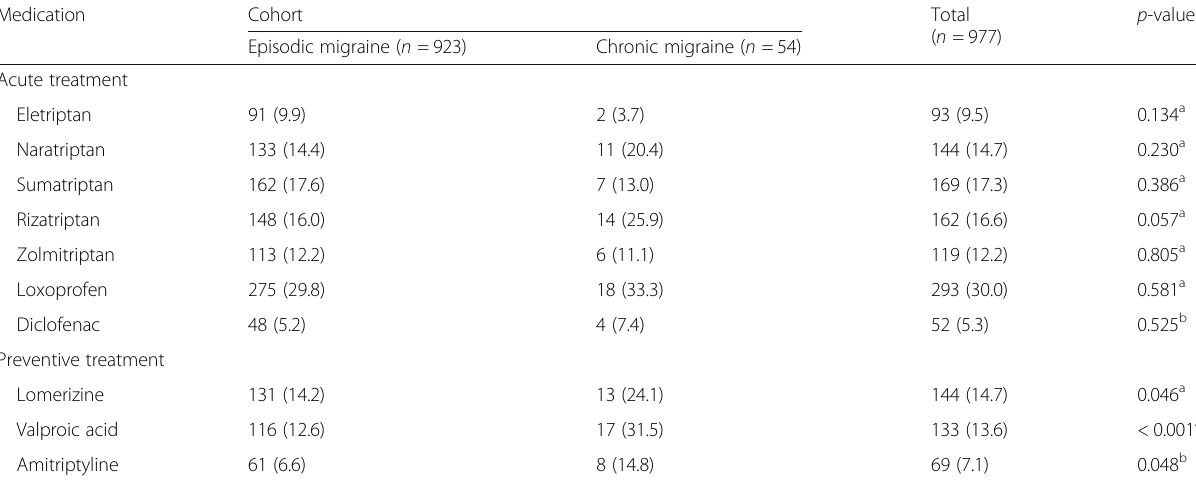
Table 3 Medications currently prescribed as acute or preventive migraine treatment for ≥ 5% of patients with episodic and chronic migraine: physician-reported data Medication